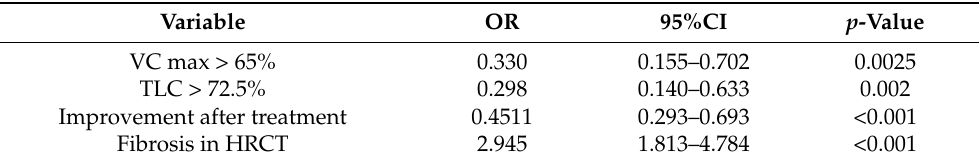
Table 6. Predictors of survival (univariate Cox regression